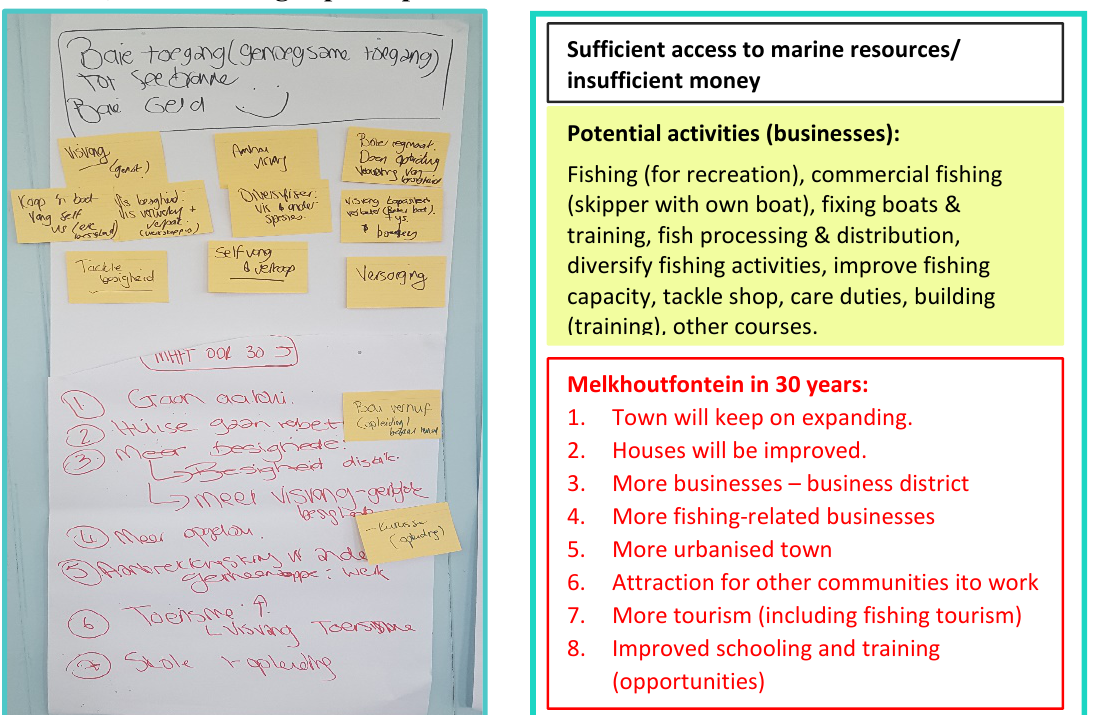
Figure A1.3. Elements of the “Insufficient access to Marine resources/Sufficient disposable income” scenario identified in workshop 3: blue cards depict future livelihood activities that participants could engage in. The red text reflects the town in 30 years. The left panel shows a photograph of the results of the original story exercise in Afrikaans, whilst the right panel provides a translation.